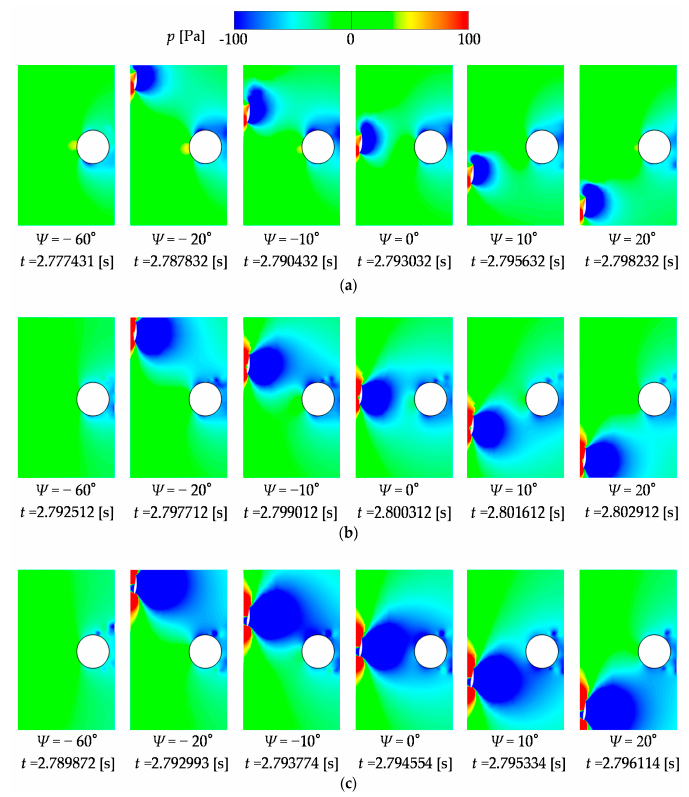
Figure 11. Horizontal distributions of the instantaneous static pressure at the mid-height of Segment 4. ( a ) λ = 3; ( b ) λ = 6; and ( c ) λ = 10.